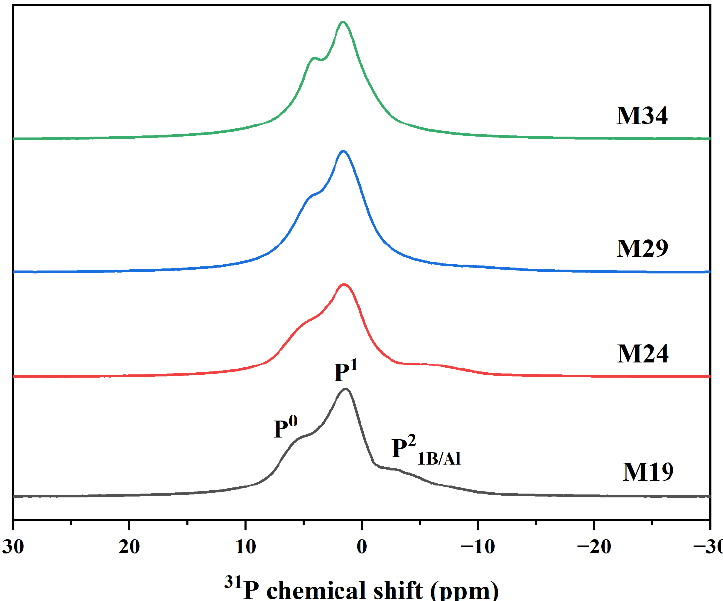
Figure 3. 31 P MAS NMR spectra of Mx series. Table 3. Nominal (measured) compositions (mol%) of the glass samples (M19, M24, M29, M34, and M34-1 samples).